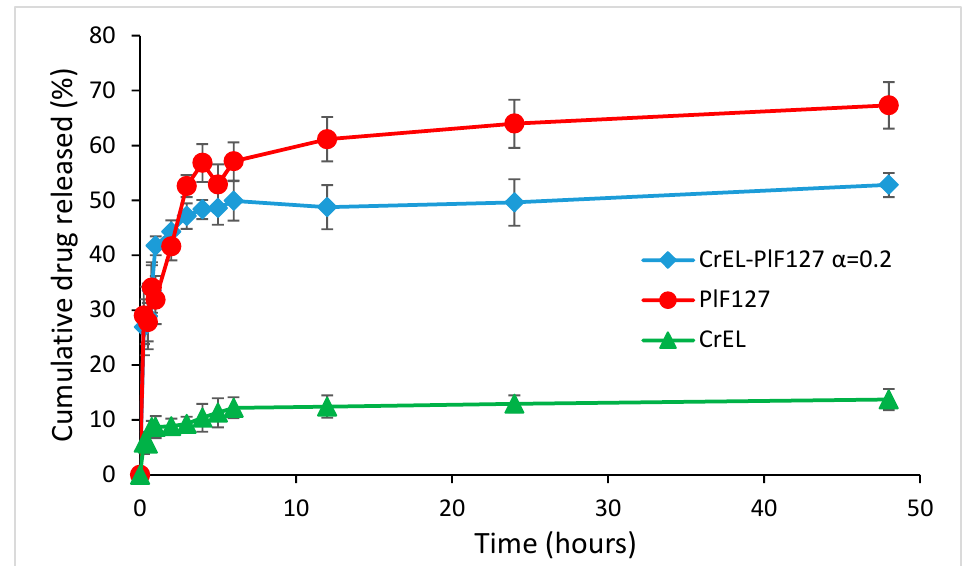
Figure 4. In vitro drug release profile for NFLX in Cremohor EL, Pluronic F127 and CrEL-Pl F127 ( α = 0.2) mixed micelles.